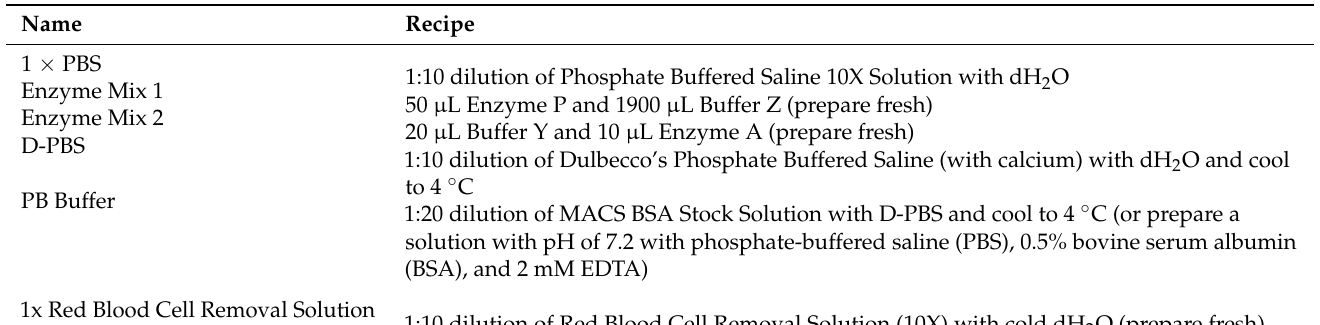
Table 3. Detailed information for solutions (to be prepared immediately before